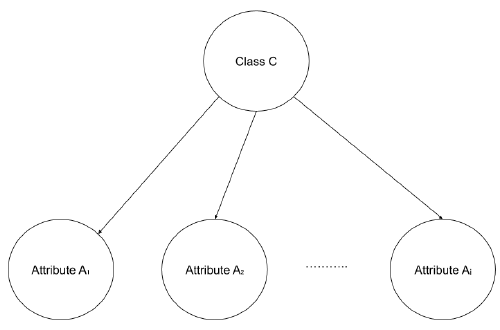
Figure 1. Bayesian network structure.